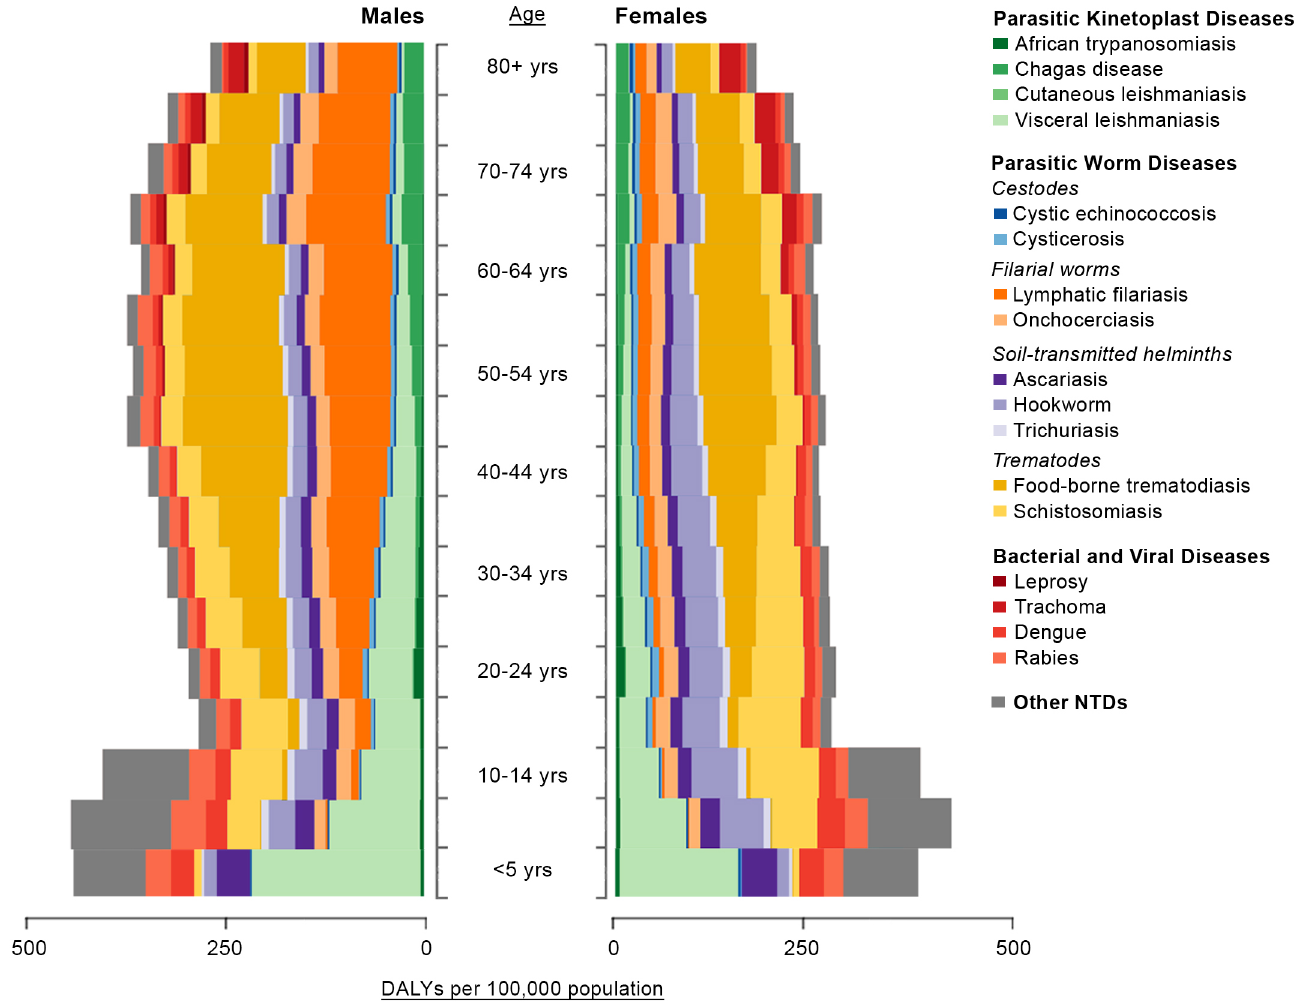
Fig 6. Disability-adjusted life years(DALYs) per 100,000population by age and gender in 2013. The estimates used to generate this figure are also availableon the Institute for Health Metrics and Evaluation (IHME) website.